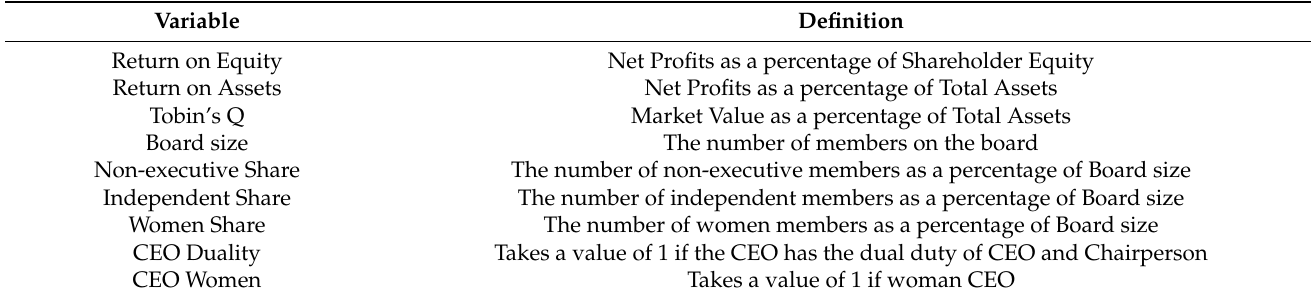
Table 1. Description of